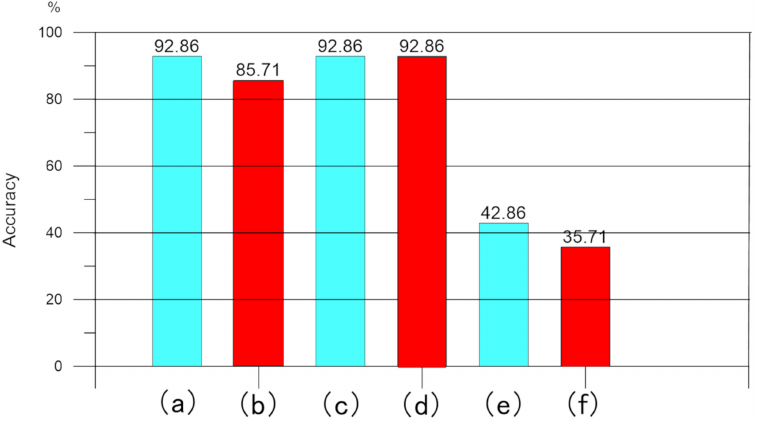
Figure 13. The accuracy of different similarity calculation methods: ( a ) the recognition accuracy of the cosine similarity using all geological entities with their TF - IDF values; ( b ) the recognition accuracy of the Jaccard coefficient using all geological entities; ( c ) the recognition accuracy of the cosine similarity using the geological entities with the top ten TF - IDF values; ( d ) the recognition accuracy of the Jaccard coefficient using the geological entities with the top ten TF - IDF values; ( e ) the recognition accuracy of the cosine similarity after removing the geological entities with the top ten TF - IDF values; ( f ) the recognition accuracy of the cosine similarity after removing the geological entities with the top ten TF - IDF